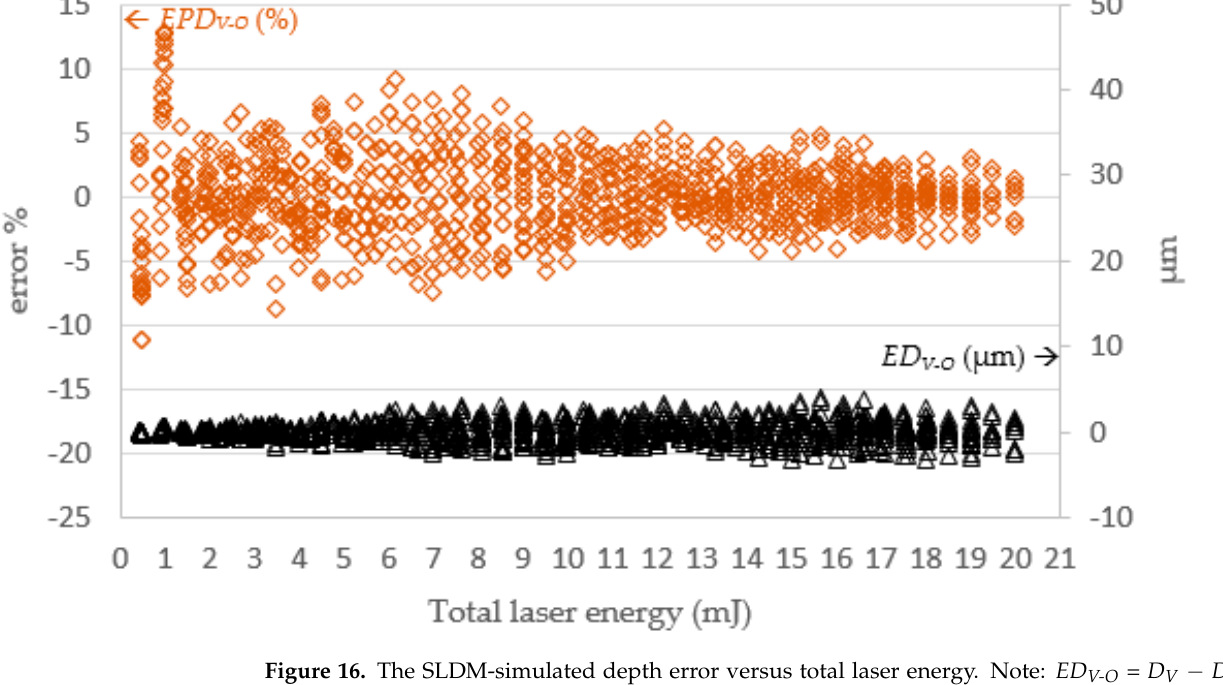
Figure 16. The SLDM-simulated depth error versus total laser energy. Note: ED V-O = D V − D O ; EPD V-O = ( D V − D O )/ D O (%). Table 7. Training and testing error for the SLDM.